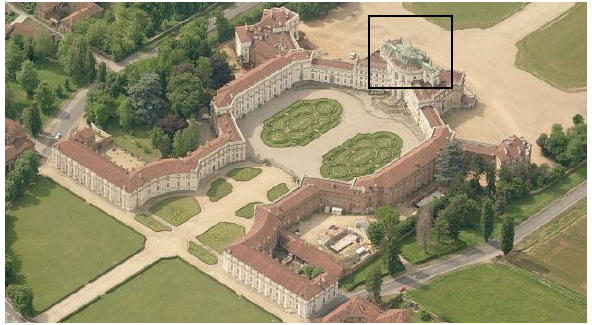
Figure 1 The Stupinigi royal estate, the hall of honour can be seen in the box.